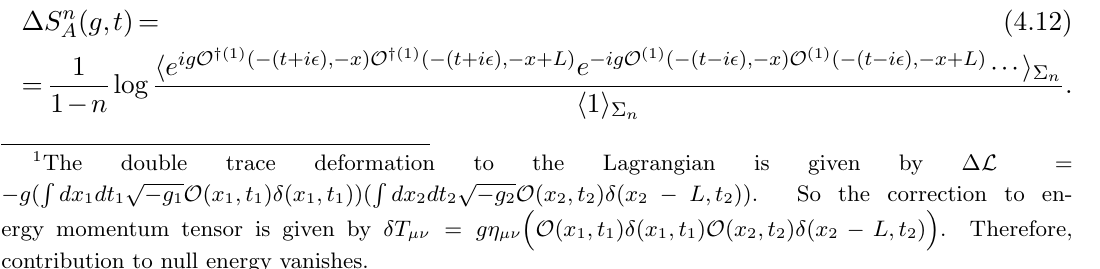
Figure 10 . When constant time slice crosses null blue line, the total energy changes by 4 (cid:25)gh (cid:0) 4 (cid:25)gh with null red line. In particular, the total energy is always 0 after double trace L 4 h +1